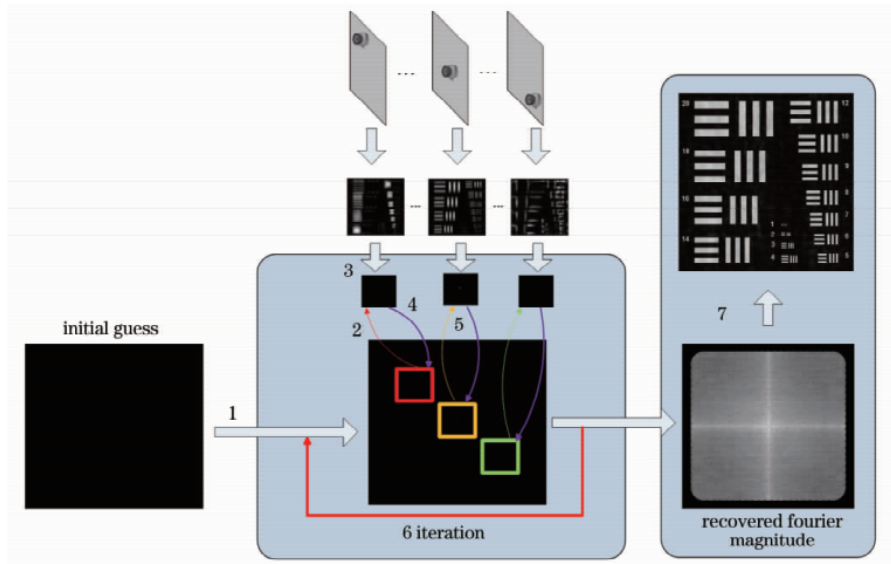
Figure 3. Entire reconstruction process of Fourier ptychography.